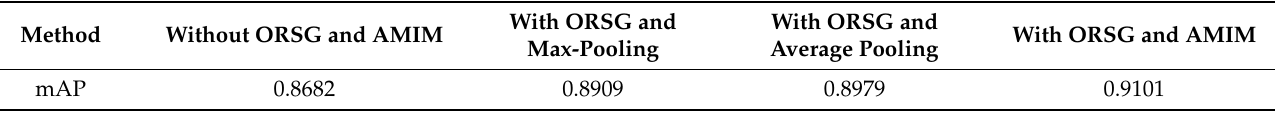
Figure 14. The detection results of ten categories of targets by MLC-PRN and SSD. (The evaluation metric: AP; Dataset: NWPU-VHR (train: 20%, val: 20%, test: 60%)). Table 6. mAP value of context fusion network using different methods. (Dataset: NWPU-VHR (train:20%, val:20%,